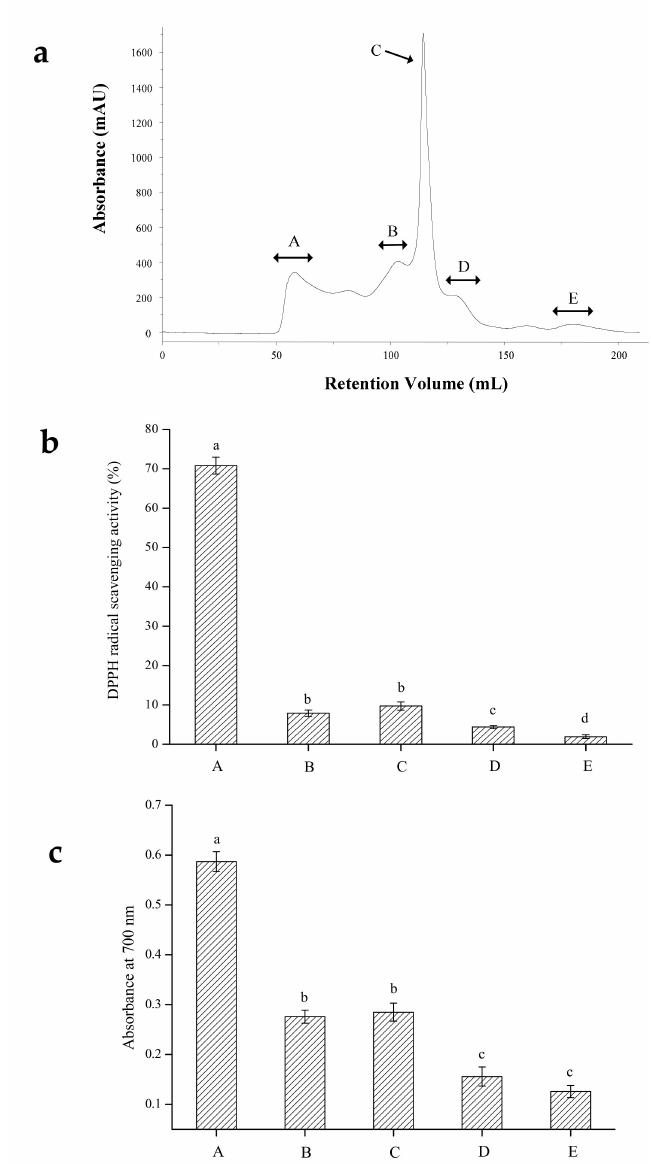
Figure 1. ( a ) Chromatogram of fraction SLH-III purified by gel filtration column; ( b ) DPPH scavenging ability of each fraction (samples at 0.5 mg / mL); ( c ) reducing power of each fraction (samples at 1 mg / mL). The columns having the same letter are not significantly di ff erent ( p >